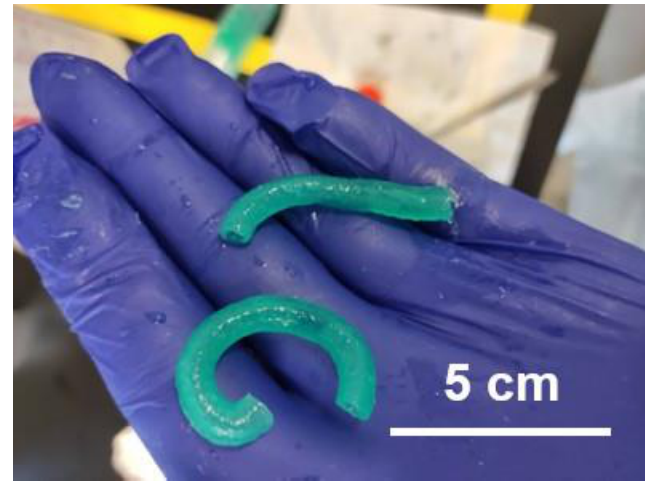
Figure 9. Alginate and Gelatin extruded ureters.